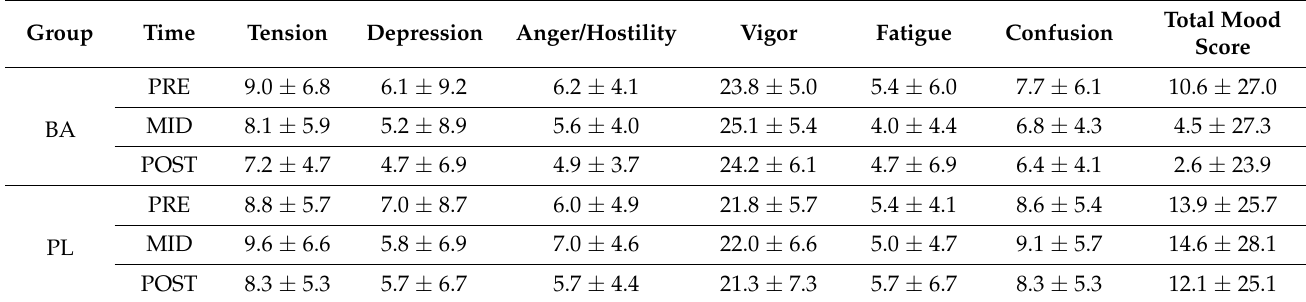
Table 1. Profile of Mood States.